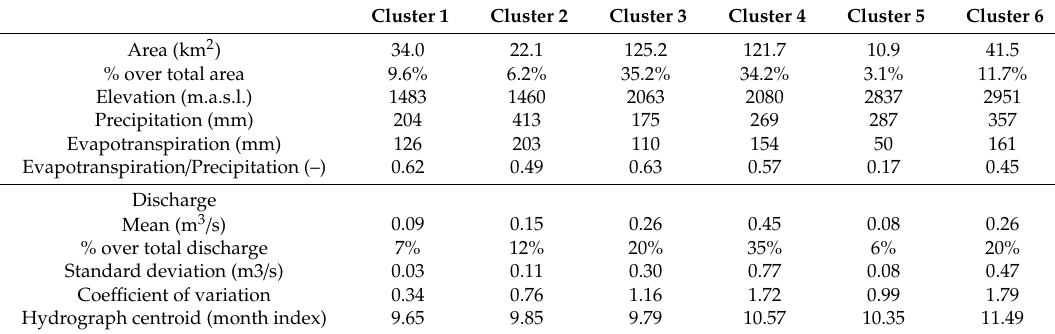
Table 3. Summary of mean annual variables for the six clusters used in the hydrological simulation. The values correspond to the mean values for the simulation period of